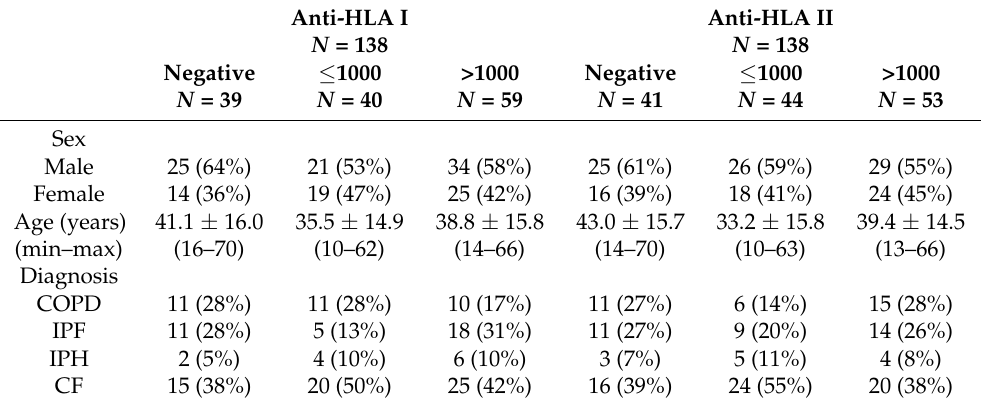
Table 3. Detailed characteristics of patients depending on MFI values in both I and II anti-HLA class.